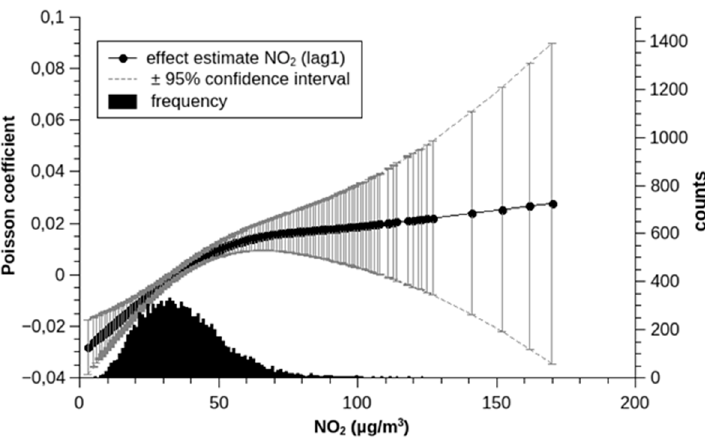
Figure 5. Concentration-response-function of previous day NO 2 in a spline model (2 degrees of freedom). Figure5. Concentration-response-functionofpreviousdayNO 2